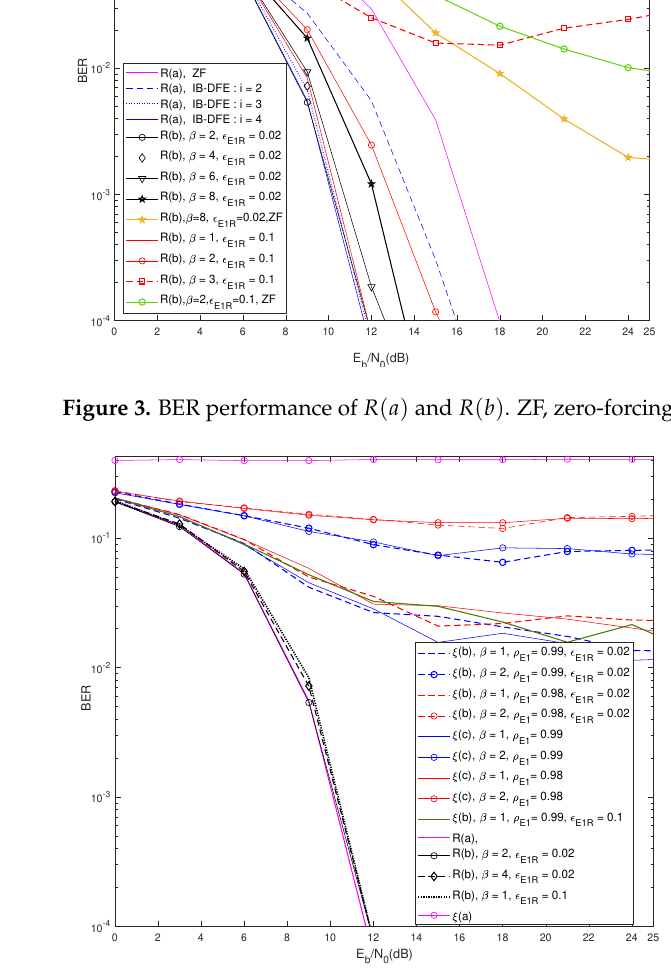
Figure 5. BER Performance of R ( b ) and R i with e E 1 R = 0.02, where R i denotes R ( b ) with an improved feedback loop in the IB-DFE receiver. Figure 5 demonstrates the impact of inclusion of βσ 2 A in the IB-DFE receiver and the results 142 validate the advantage of using (23) over (21) in the iterative loop. R i has significant SINR gain over 143